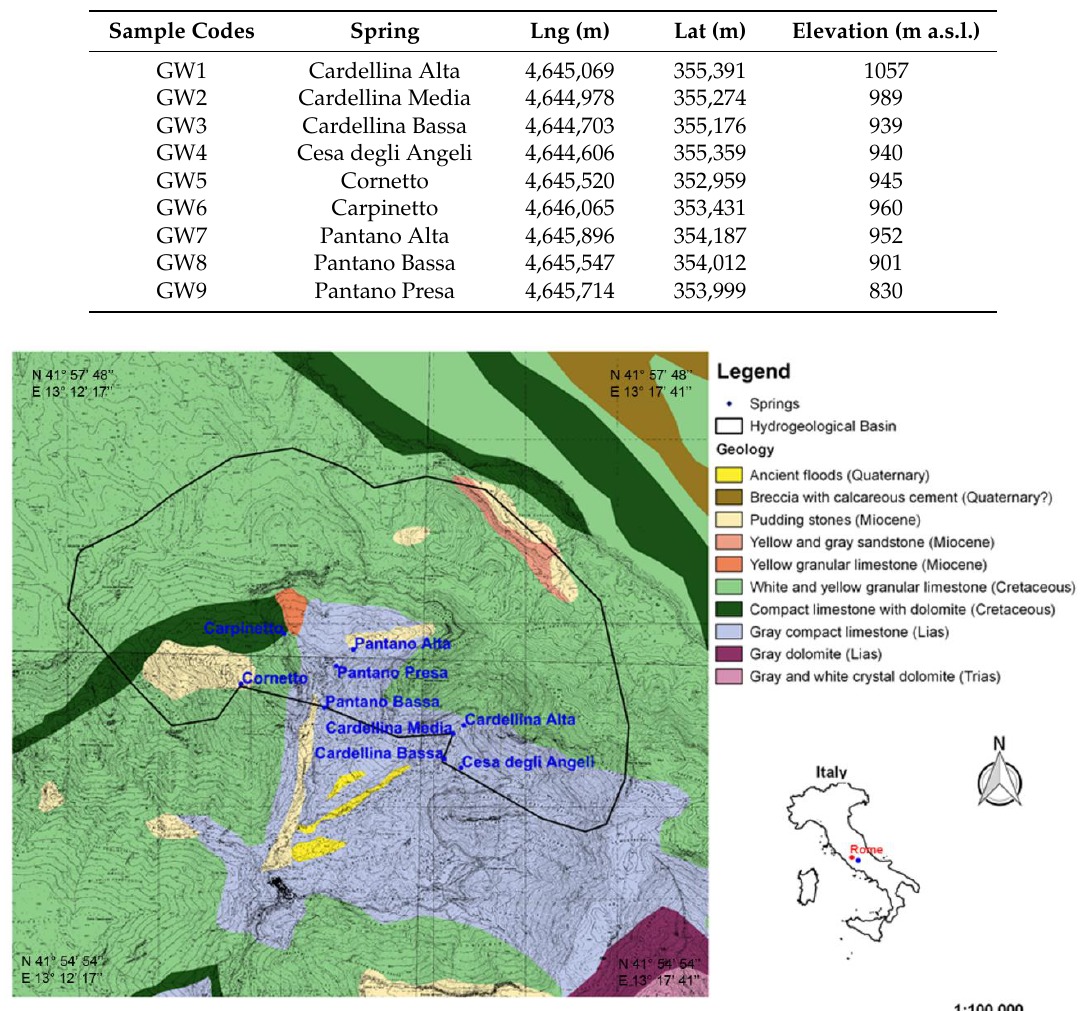
Table 1. Sampling location of the study area.